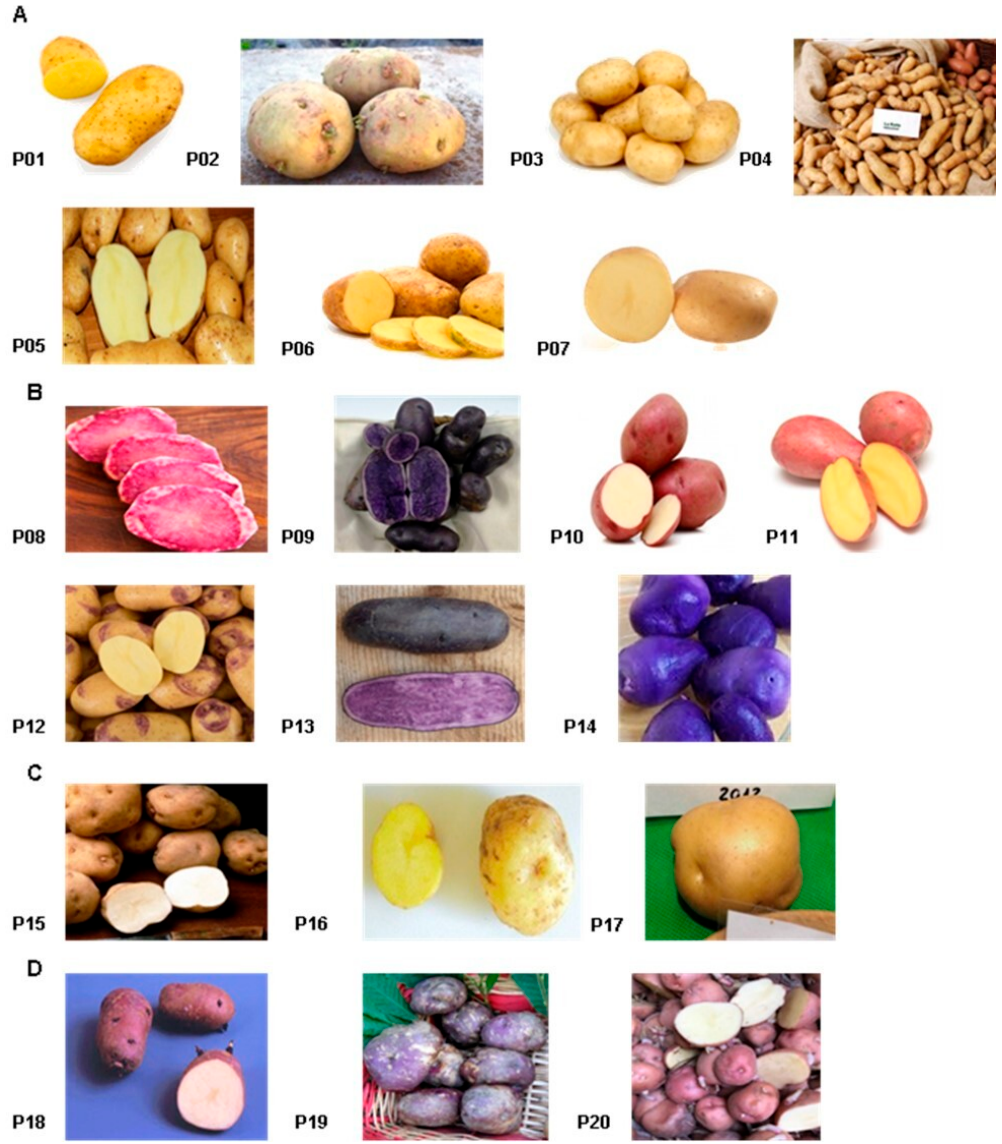
Figure 1. Piedmont cultivars characterized by yellow peel and yellow pulp ( A ) and colored peel and / or pulp ( B ). Liguria cultivars characterized by yellow peel and yellow pulp ( C ) and colored peel and yellow pulp ( D ).